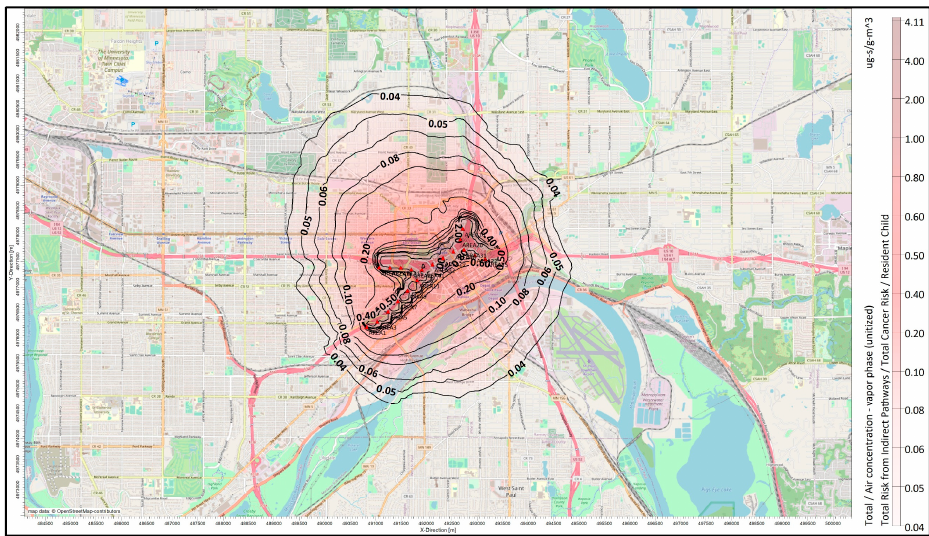
Figure 6. Benzene Annual Air Concentration—Vapor Phase (Unitized) Contour Plot overlaid on OpenStreetMap Satellite Imagery (OpenStreetMap, n.d.). Unit used in contour is µg-s/g-m 3 .